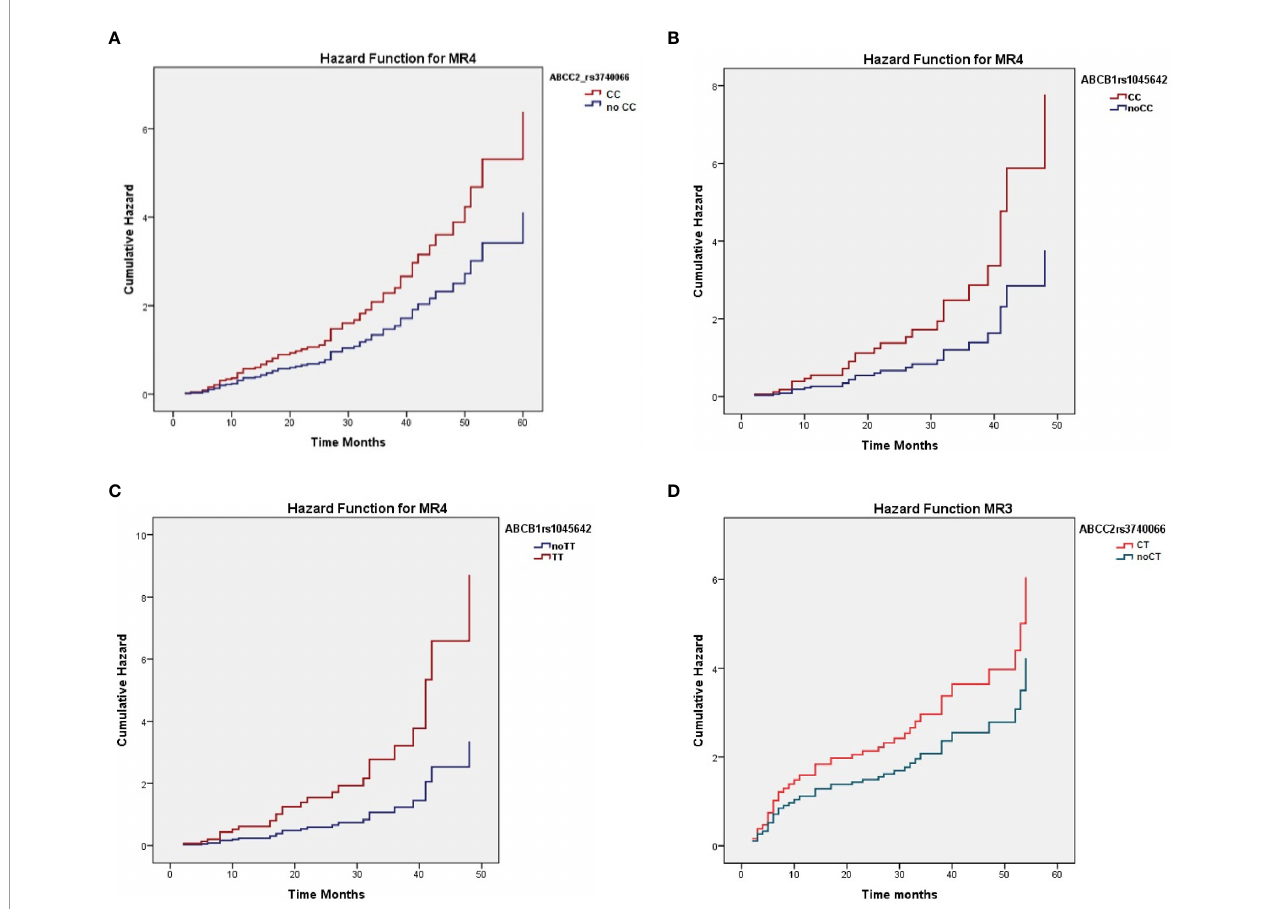
FIGURE 1 | Correlation between ABCC2 rs3740066 CC (A) , ABCC2 rs3740066 CT (B) , ABCB1 rs1045642 TT (C) ABCG2 rs2231137 GG (D) genotypes and MR3